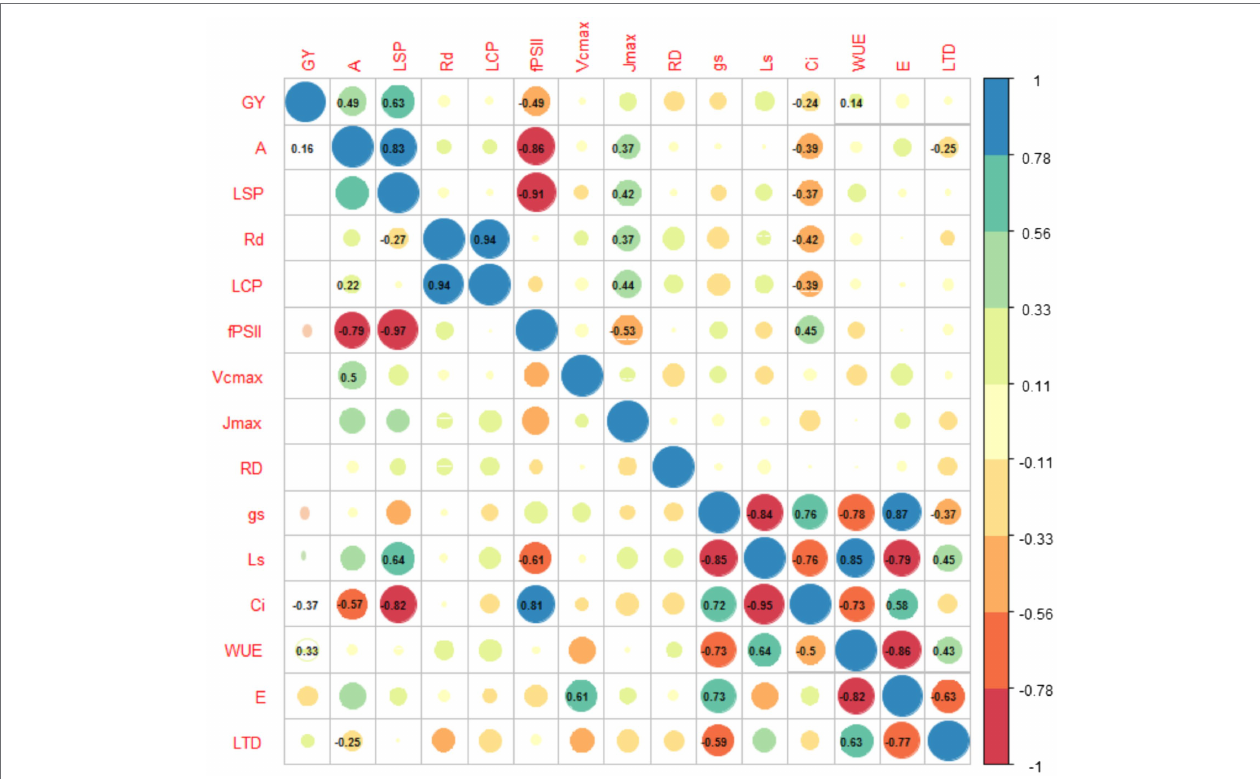
FIGURE 7 | Correlation between the different physiological variables of different genotypes grown at high temperatures. Below and above the diagonal, values correspond to the correlations for the EUW (Effective Use of Water) and WUE (Water use efficient), respectively. The blue and red are the positive and negative correlation, respectively, accompanied by the magnitude of the correlation by the size of the circle. Only significant correlations ( p < 0.05) appear within the circles. The acronyms are shown in Table 1